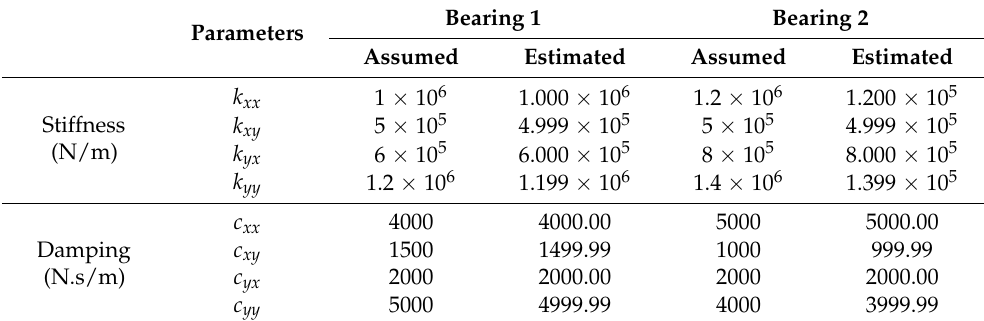
Table 4. Assumed and estimated stiffness and damping parameters of the two bearings.